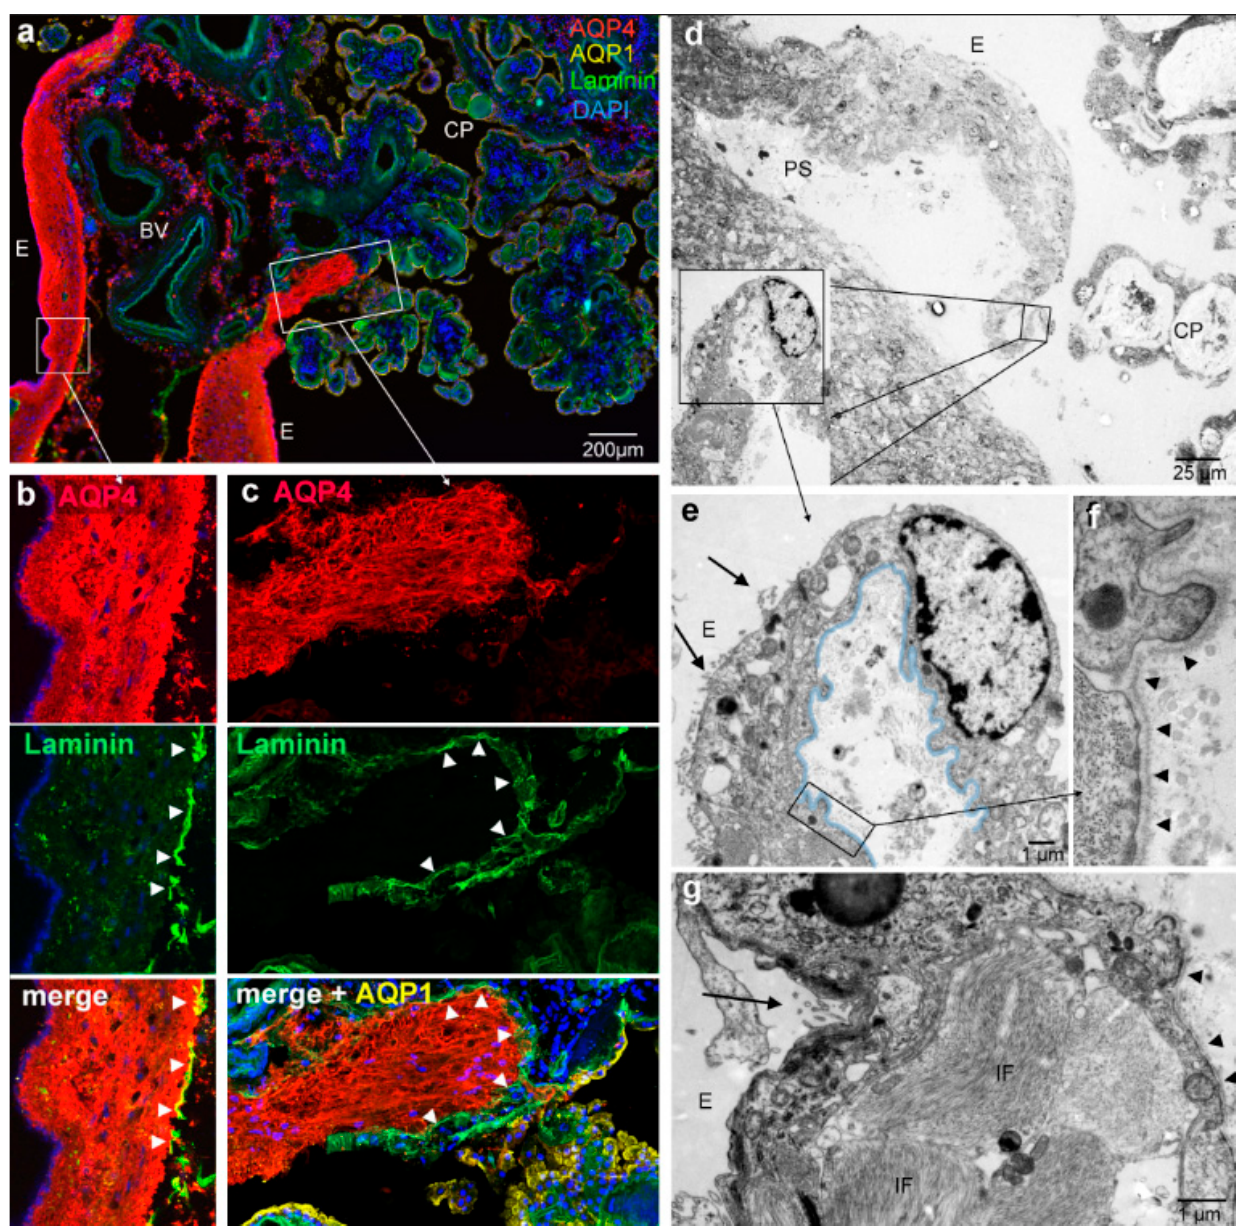
Figure 3. The transitional glial plate is delimited by a basal lamina. ( a ) Immunolabeling for AQP1, AQP4 and laminin reveals a basal lamina under the CP epithelial cells that are apically positive for AQP1. Higher magnification of the indicated areas shows that there is a basal lamina (arrowheads) bordering the astrocytic processes and surrounding blood vessels. ( b ) Moreover, astrocytic pro- cesses extending into the stroma ( c ) of the CP are surrounded by laminin staining ( c , arrowheads ). ( d – g ) Electron micrographs of the transition zone between ventricle lining ependyma and choroid plexus epithelium. ( d ) An overview of an ependymal/glial surrounding of blood vessels which turns into a single-layered epithelium towards the CP villi on the right. ( e ) Higher magnification of the boxed areas as indicated shows a continuous basal lamina (highlighted in blue) from the multi- layered ependymal side (left) to the single cell layer (right, cell with nucleus). Ependymal cells have apical microvilli (arrows) and occasional cilia. ( f ) Detailed view of the basal lamina under astrocytic processes (arrowheads). ( g ) Astrocytic processes under ependymal cells (E) show large bundles of